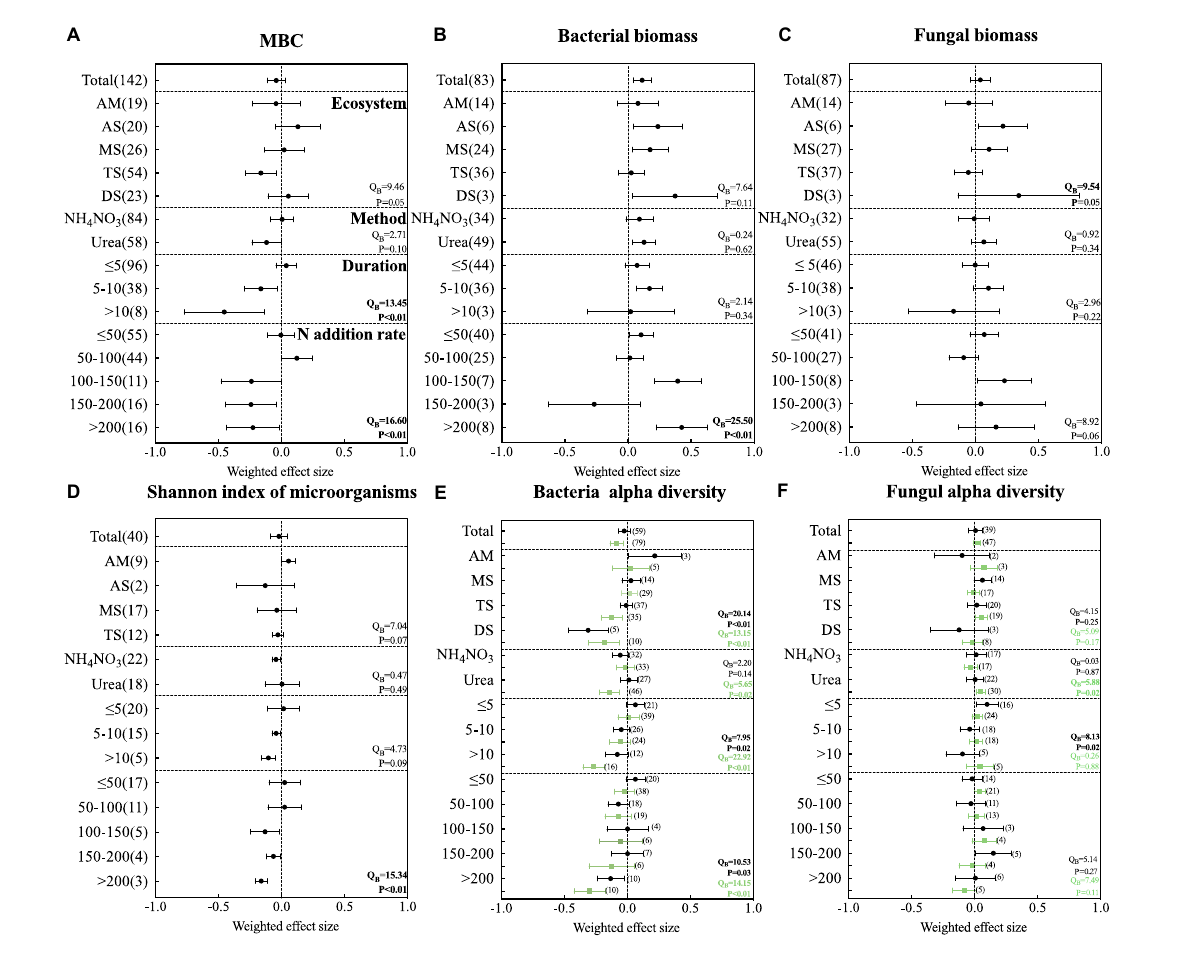
FIGURE5 Effects of N addition on (A) microbial carbon, (B) bacterial biomass, (C) fungal biomass, (D) shannon index of microorganisms, (E) bacterial alpha diversity and (F) fungal alpha diversity. The variables are categorized into different ecosystems (AM, alpine meadow; AS, alpine steppe; MS, meadow steppe; TS, typical steppe; DS, desert steppe); fertilizer types (NH 4 NO 3 and urea), experiment durations, and N application rates. Error bars present 95% confidence intervals. The dashed line was drawn at a mean response ratio = 0. If 95% CI does not overlap zero, then microbial diversity in fertilized soils differed significantly from those in unfertilized soils. The numbers in parentheses next to the point represent the number of studies. In Panels (E,F) , black represents Shannon index and green represents chao1